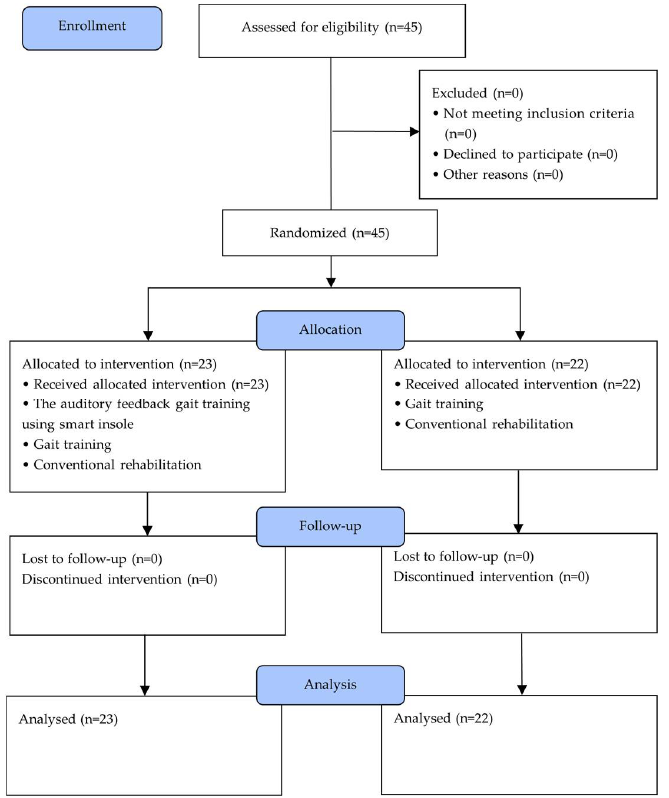
Figure 1. Experimental